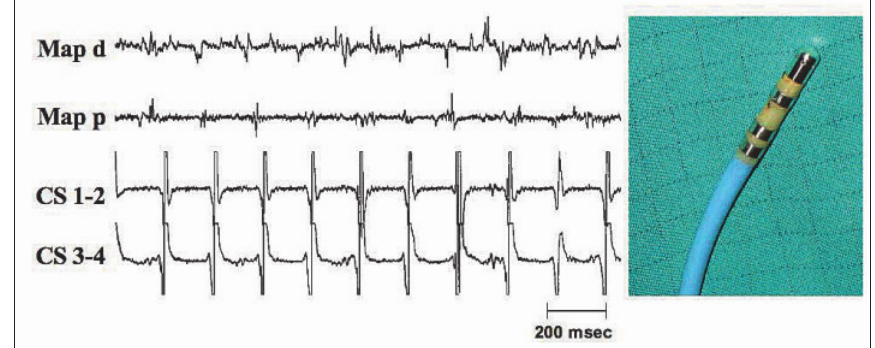
Left: Example of a complex fractionated atrial electrogram (CFAE) recorded with the distal pole of the mapping catheter (Map d) at a septal site in the left atrium. Note the high degree of fractionation and short cycle length of the electrogram on Map d. In contrast, the electrogram in the coronary sinus (CS) is well organised with a relatively stable cycle length of approximately 180 msec. Right: A 3.5-mm irrigated-tip catheter (Thermocool, Biosense Webster Inc. Diamond Bar, CA, USA) used for mapping (and